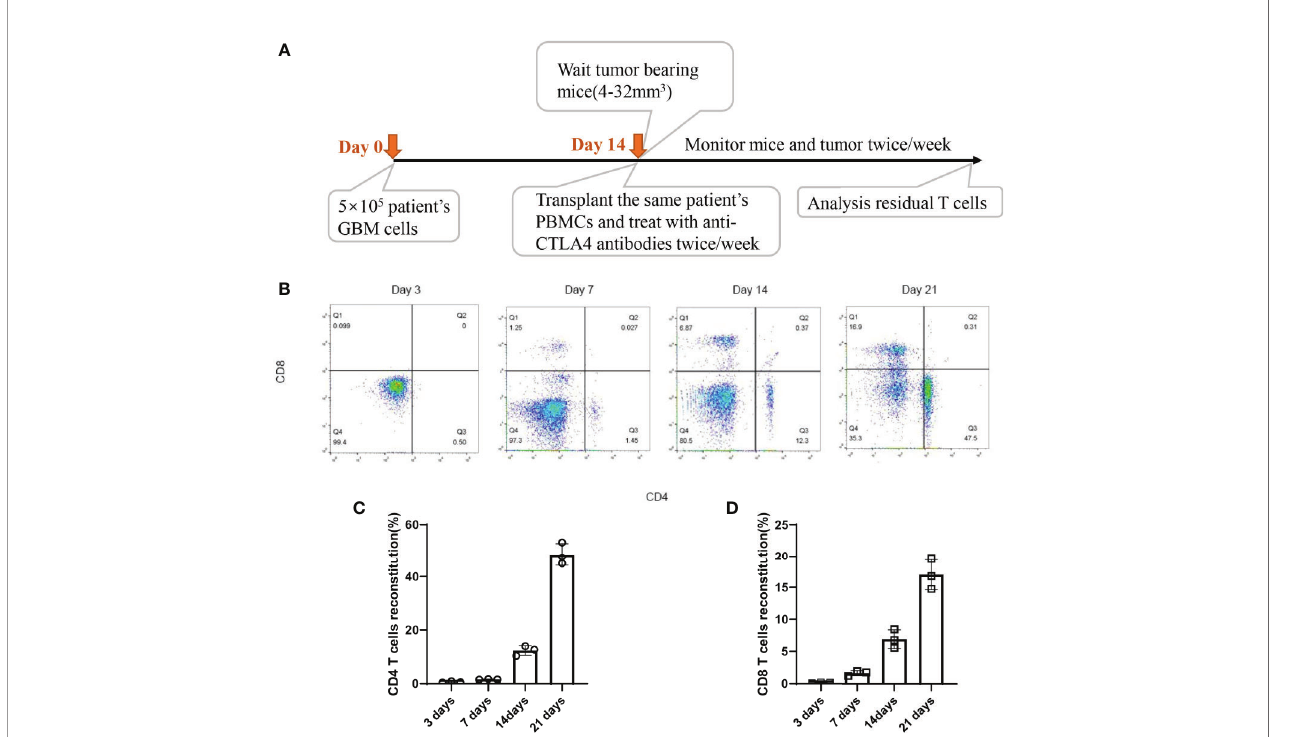
FIGURE 2 | The reconstitution of T cells derived from GBM patients in HPDOX mice model. (A) Timepoint of the construction of HPDOX mice model. (B) Flow cytometry analysis of CD4 + and CD8 + T cells in NSG mice with transplanted PBMCs. (C, D) The population of CD4 + (C) and CD8 + (D) T cells in NSG mice with transplanted PBMCs. Each experiment was repeated at least three times, and three repeats were included each